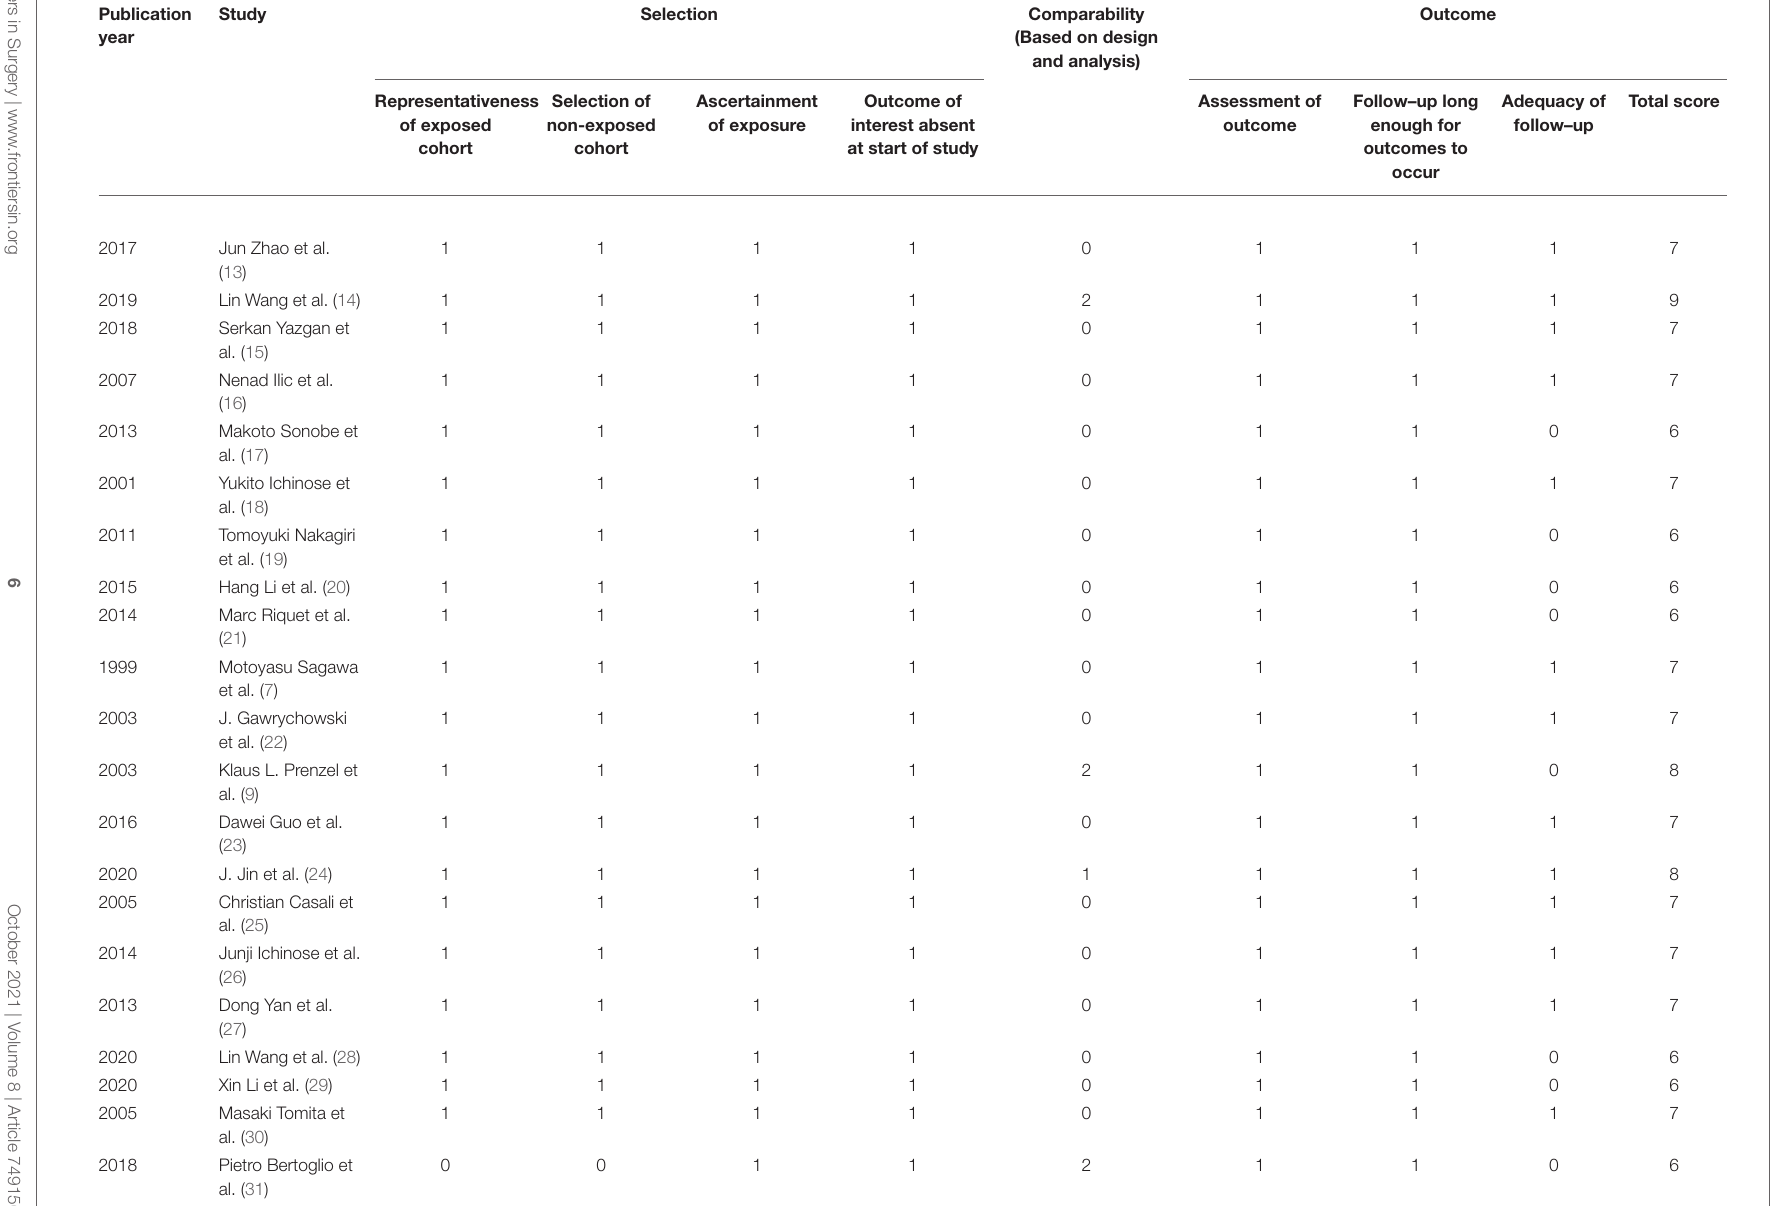
TABLE 2 | Quality assessment of the nonrandomized studies using the Newcastle–Ottawa